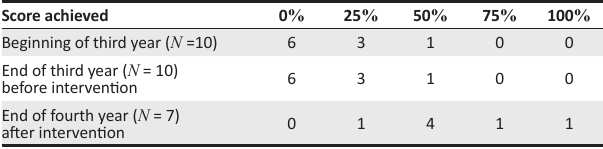
TABLE 5 : Dosage results for sample of very weak students ( N = 10; 3 not included in final